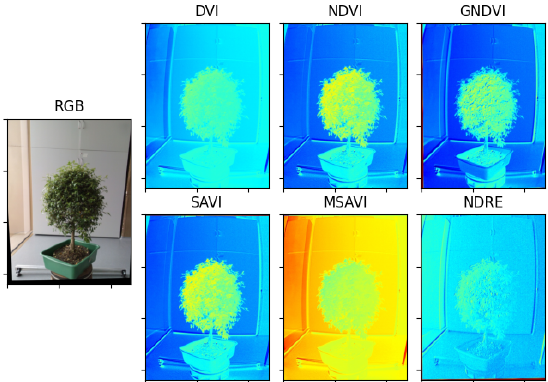
Figure 13. Result of the estimation of vegetative indexes in the Guayacan plant.